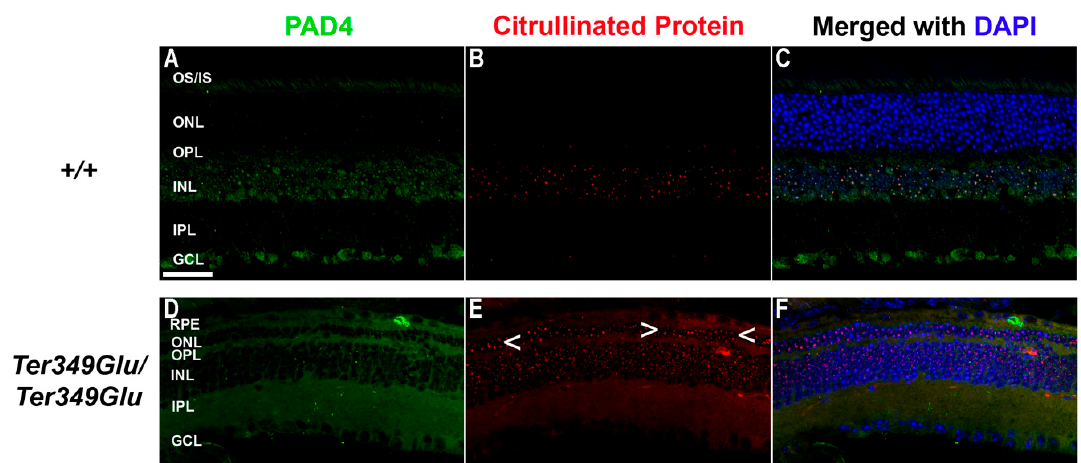
Figure 7. Expression of PAD4 and citrullination of retinal proteins in normal and degenerated states. WT ( +/+, A – C ) and Ter349Glu/Ter349Glu ( D – F ) mice at 10 to 12 weeks of age were labeled for PAD4 (green) and citrullinated peptides (red). Nuclei were labeled with DAPI (blue). Arrowheads (<), areas of increased citrullination in ONL; OS/IS, photoreceptor outer and inner segments; IPL, inner plexiform layer; Scale bar = 20 μ m.